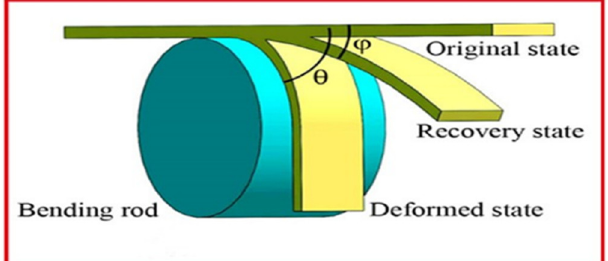
Figure 14. Schematic representation of the bending test to determine the strain recovery effect, adapted with permission from [70], 2022, Elsevier.